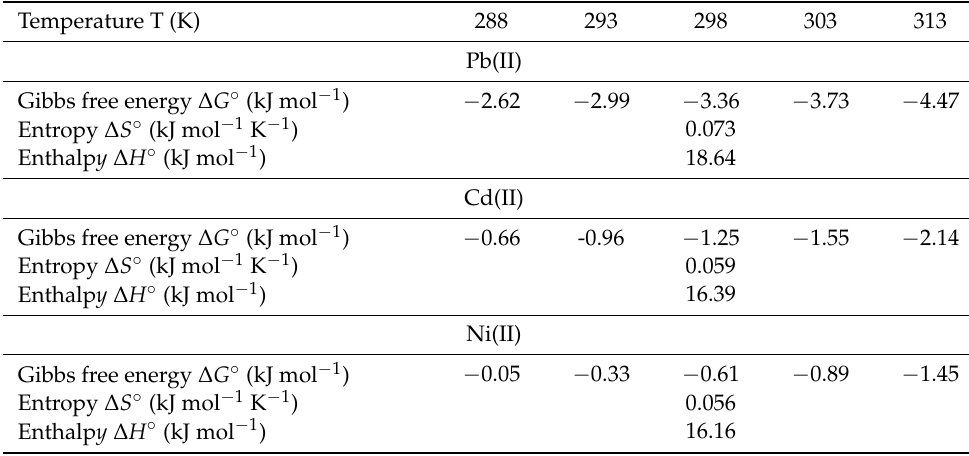
Table 5. Values estimated from the thermodynamic